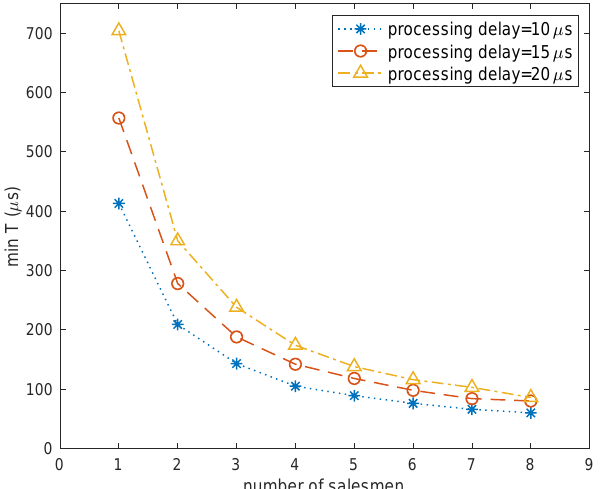
Figure 13. The effect of changing the number of salesmen on min ( T ) when using Algorithm 1.